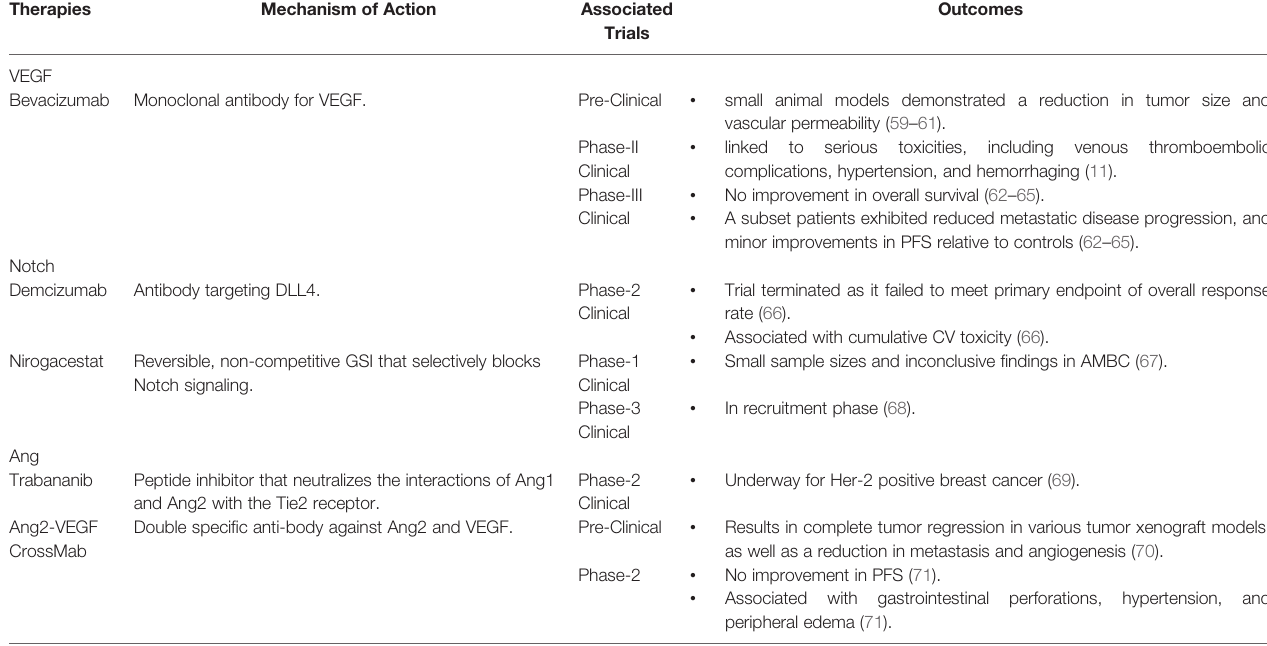
Outcomes Trials